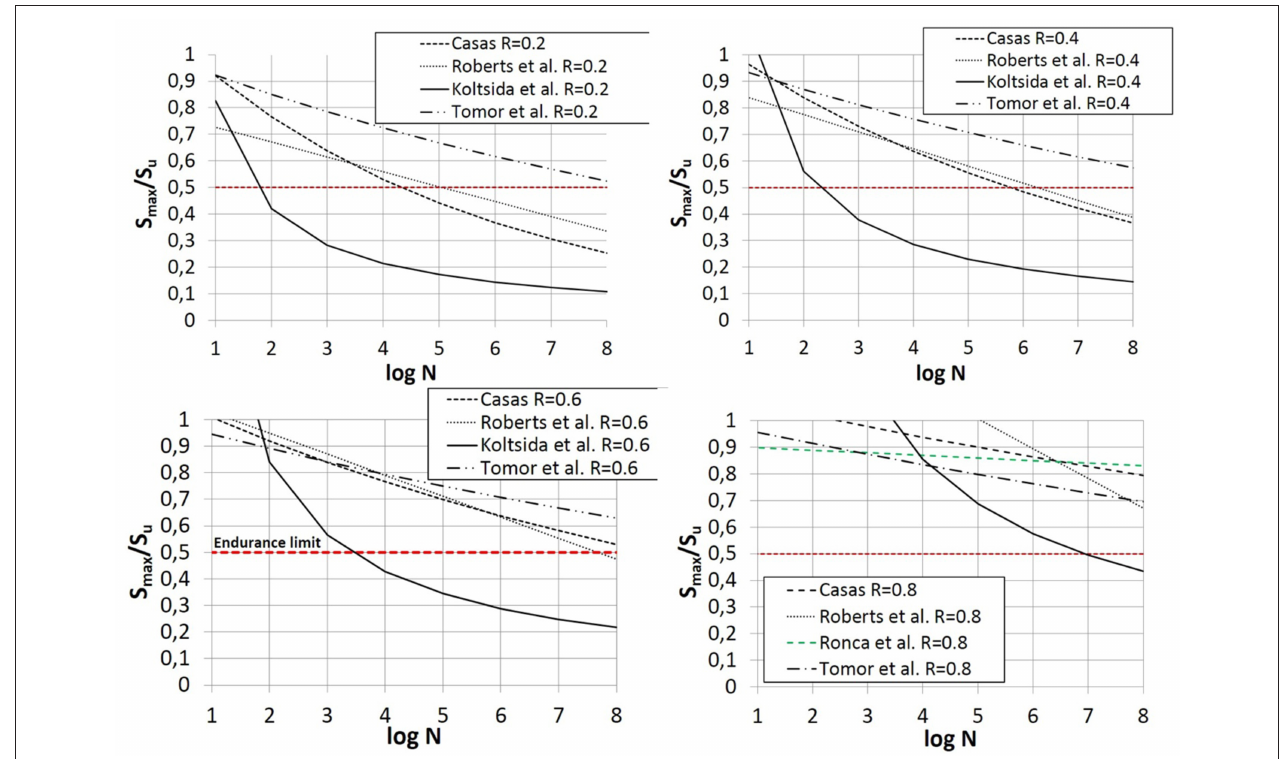
FIGURE 5 | Comparisons between stress life curves for different values of the ratio R, referred to the 5% of failure